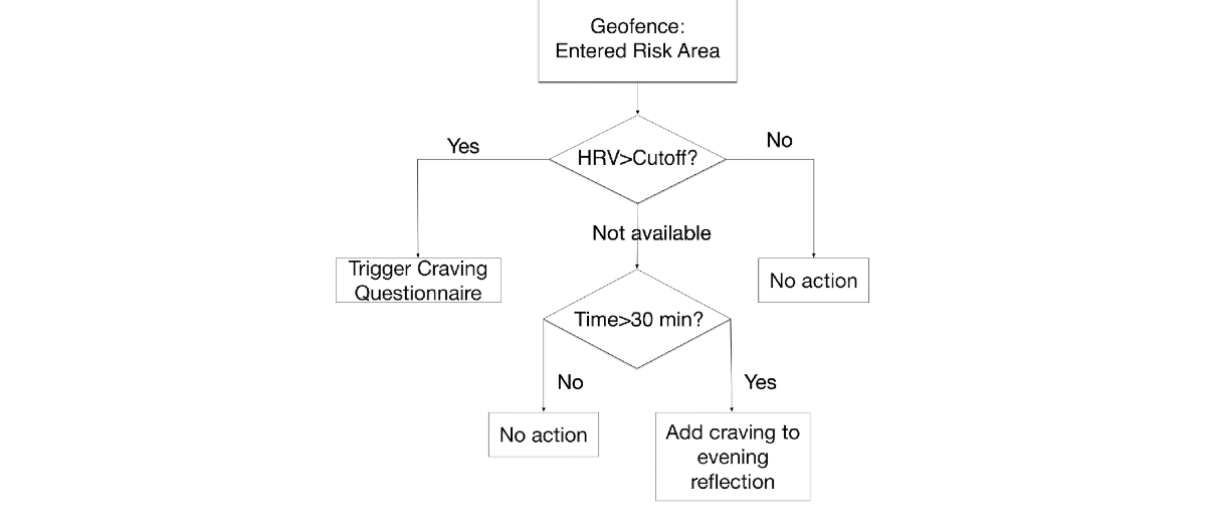
Figure 2. A hypothetical example of a decision tree for triggering different interventions. HRV: heart rate